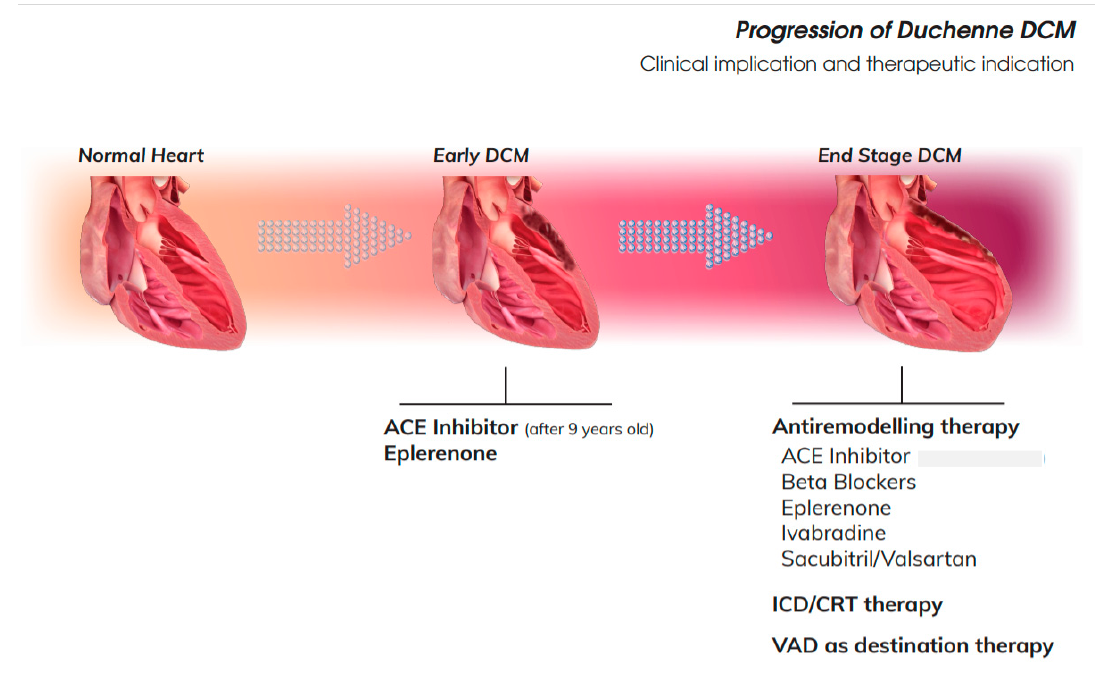
Figure 2. Progression of DMD-DCM. According to clinical stage of the DMD-DCM, different strategy might be considered. ACE: Angiotensin Converting Enzyme; CRT: Cardiac Resyncronization Therapy; ICD: IntraCardiac Defibrillator; VAD: Ventricular Assist Device.